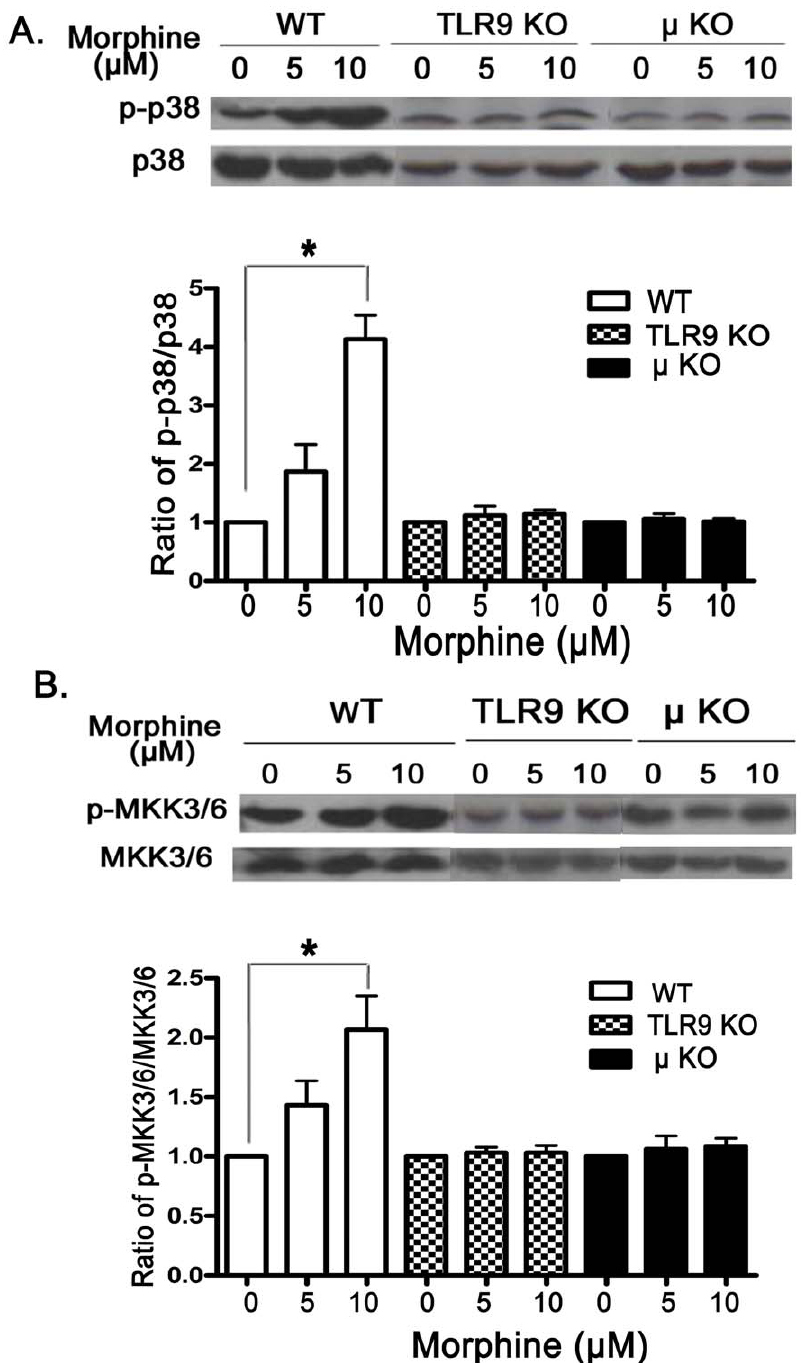
Figure 6. Effect of morphine on p38 MAPK and MEKK3/6 activation. WT, TLR9 KO, and m OR KO microglial cells were treated with morphine at 5 and 10 m M for 24 hr. (A) Total and phosphorylated p38 MAPK (p-p38 MAPK) levels were determined by Western blot. Mean values were derived from three independent experiments. * p , 0.01 compared with indicated groups. (B) Total and phosphorylated MKK3/6 (p-MKK3/6) levels were examined by Western blot. Mean values were derived from three independent experiments. * p , 0.01 compared with indicated groups.